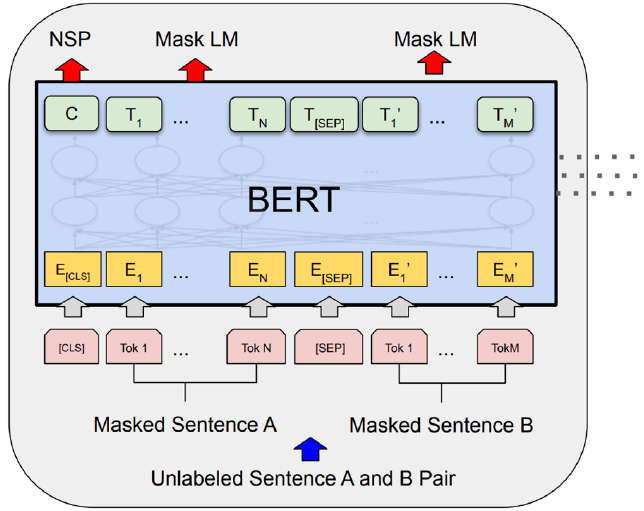
Figure 2. Architecture of BERT in